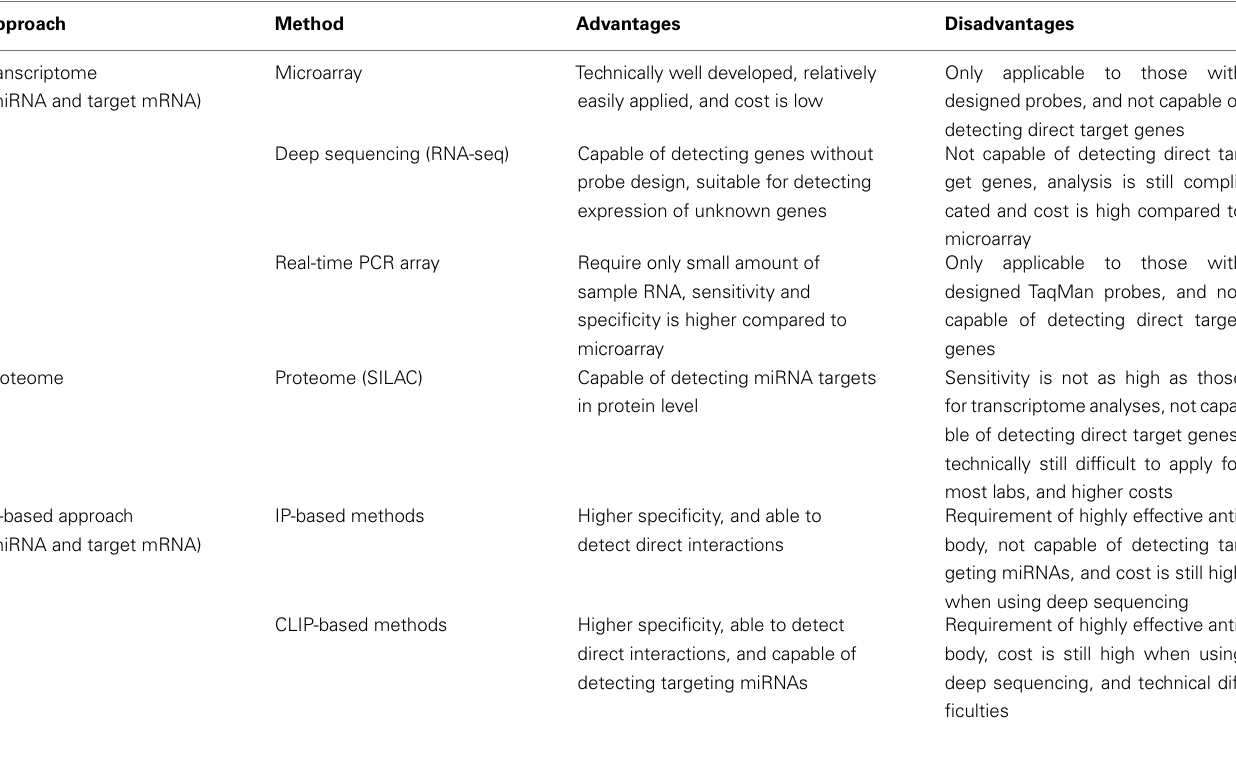
Table 1 | Systems-level approaches to identifying miRNA